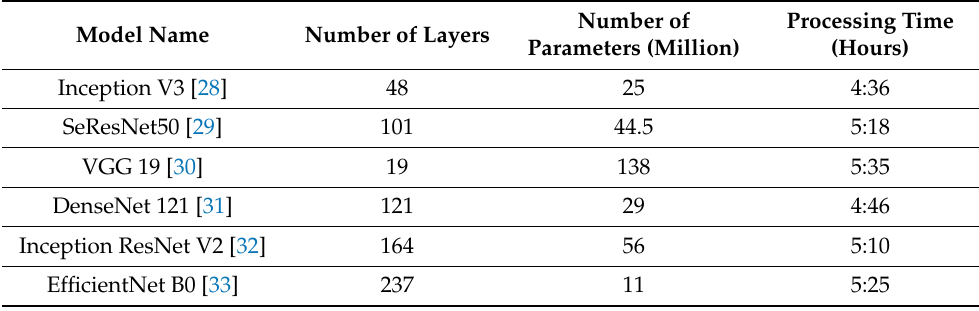
Table 2. Comparison of Transfer Learning